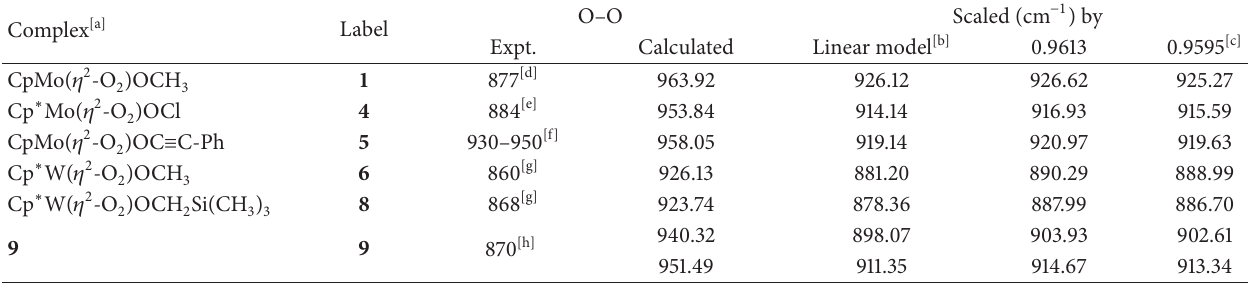
Table 10: Results of O–O stretches for variuos Molybdenum and Tungsten complexes. O–O Scaled (cm −1 ) by Complex [a] Label